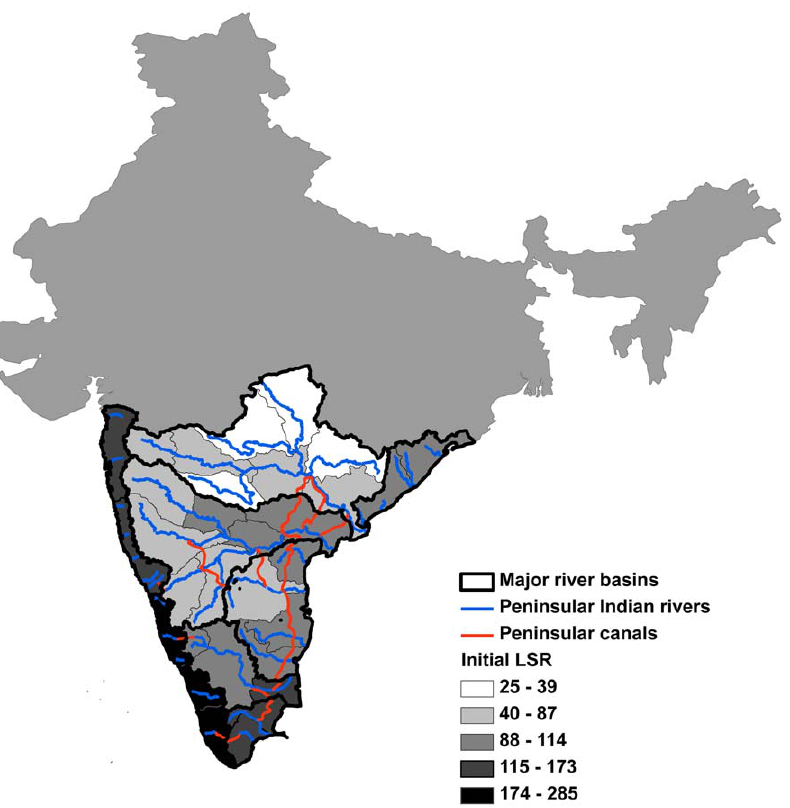
Figure 1. Map of peninsular India. Showing the 8 major river basins (thick black lines), 31 sub-basins (thin black or gray lines), major rivers (blue lines), 11 proposed canals under India’s Interlinking of Rivers Programme interbasin water transfer plan (IBWT; red lines), and the initial local species richness (LSR; grey shading).